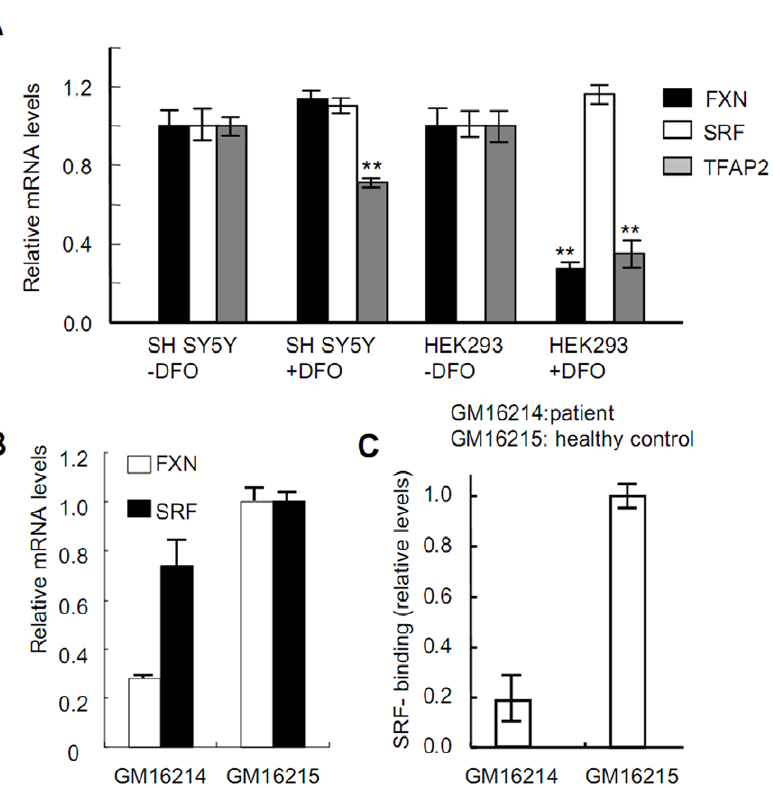
Figure 4. Cellular iron depletion decreases frataxin expression. (A) Iron depletion decreases frataxin and TFAP2 mRNA levels in tested cells. qRT-PCR was performed to quantify the mRNA levels of frataxin, SRF, and TFAP2 in SHSY5Y and HEK293 cells following treatment with 30 m M DFO for 48 hours. GAPDH was used as an internal control. Three separate experiments were carried out. For each experiment, duplicate iron treatment was performed. The error bars represent standard deviation. Statistical analysis was performed using the Student’s t -test: **: r , 0.001. (B) mRNA levels of SRF and frataxin in lymphoblasts derived from patient (GM16214) and healthy control (GM16215). qRT-PCR was performed to quantify the mRNA levels of frataxin and SRF with the total RNA isolated from patient and control. (C) Binding of SRF to the FXN promoter is dramatically decreased in patient lymphoblasts. ChIP assays were conducted as described in Figure 1. The relative expression level in the patient cells is normalized to the healthy control cells, which are set at 1.